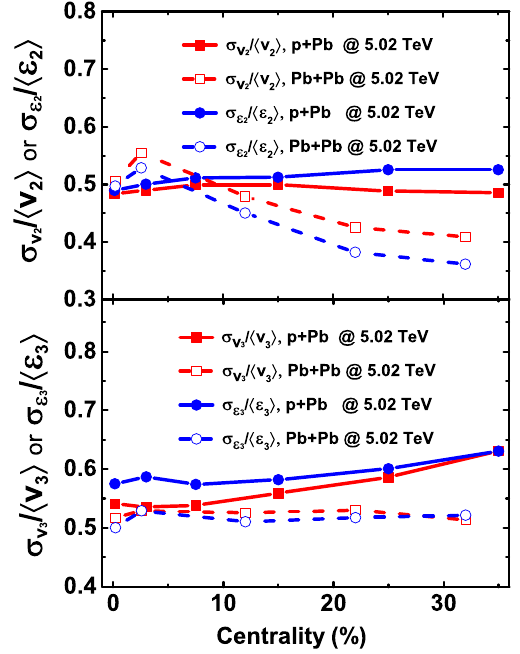
/ (cid:2) v (cid:3) and σ (cid:12) / (cid:2) (cid:12) (cid:3) as a function of centrality class in 5.02 Fig. 15 σ v n n n n TeV p + Pb collisions for n = 2 and 3, compared to calculations in